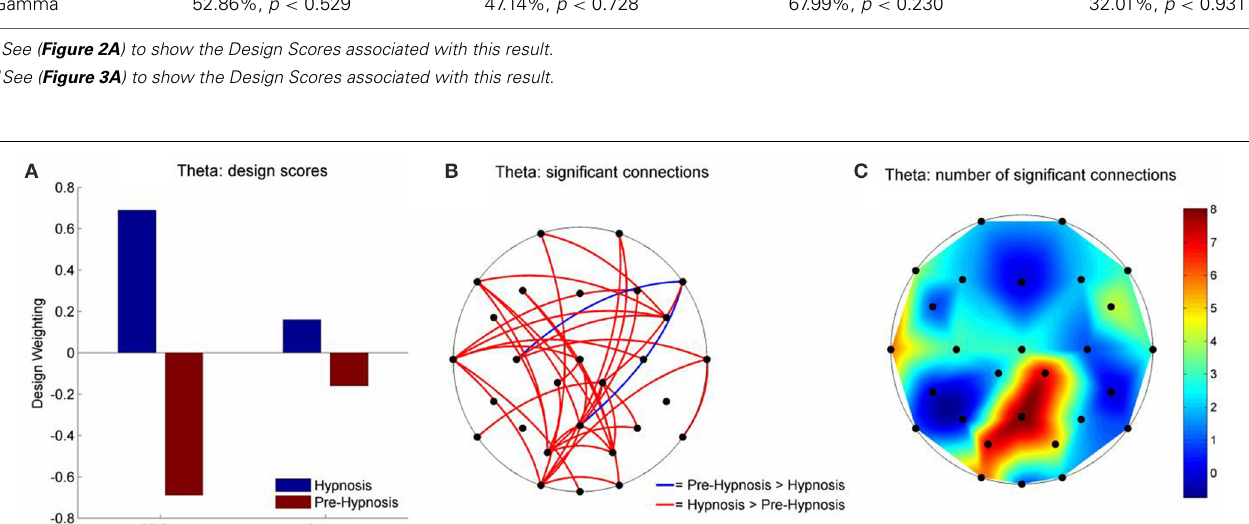
the Design Scores, the red lines indicate those connections where there was an increase in iCOH from the pre-hypnosis state to the hypnosis state in the high susceptible participants; Blue lines indicate those connections where there was a decrease. (C) Shows the number of significant changes in iCOH associated with each electrode site. In this case, there was a hub of connections focused on the central-parietal region that was maximal at